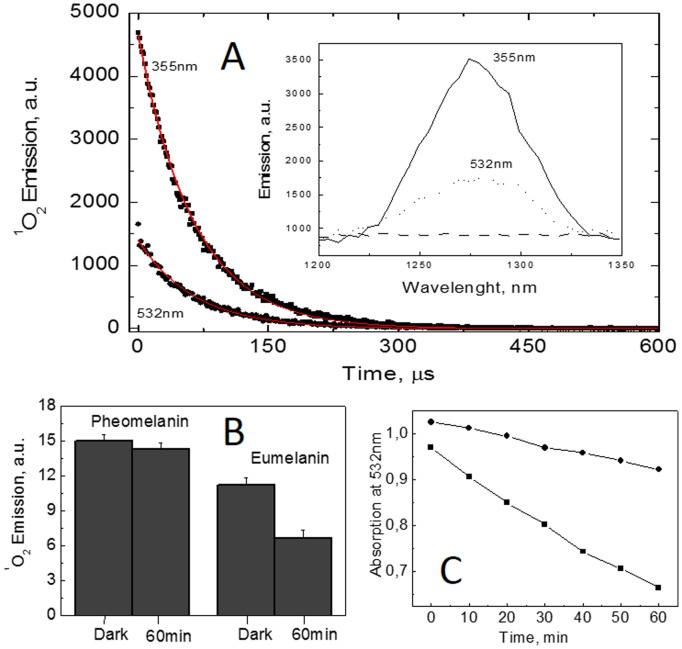

1O2 generation from melanin.(A) 1O2 decay from a eumelanin solution (0.04 g.L−1) in acetonitrile, pD = 10 with excitation at either 355 or 532 nm. The 1O2 decay lifetimes were the same under both conditions (∼17 µs, which is the lifetime expected for a mixture of acetonitrile and water) [18]. The insert shows the near infrared emission spectra after exciting a eumelanin solution at 532 nm and 355 nm in the absence of azide (continuous lines) and in the presence of 3 mM azide (dashed flat line); for the excitation pulses at both 355 nm and 532 nm, we used the following parameters: 5 ns, 10 pulses/s, and 1 mJ/pulse. (B) An integral of the emission spectra from pheomelanin (OD = 1.02) and eumelanin (OD = 0.97) solutions in acetonitrile immediately following dissolution (dark) and after 60 min of irradiation with visible light (light dose of 12 J.cm−2). (C) Absorption as a function of irradiation time for pheomelanin (•) and eumelanin (▪) solutions in acetonitrile.